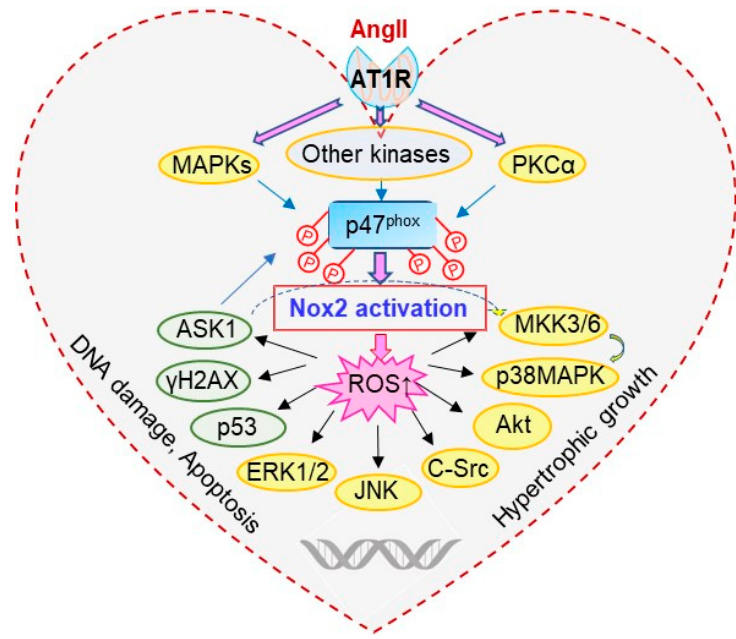
Figure 7. Schematic illustration of p47 phox redox ‐ signalling pathways examined.